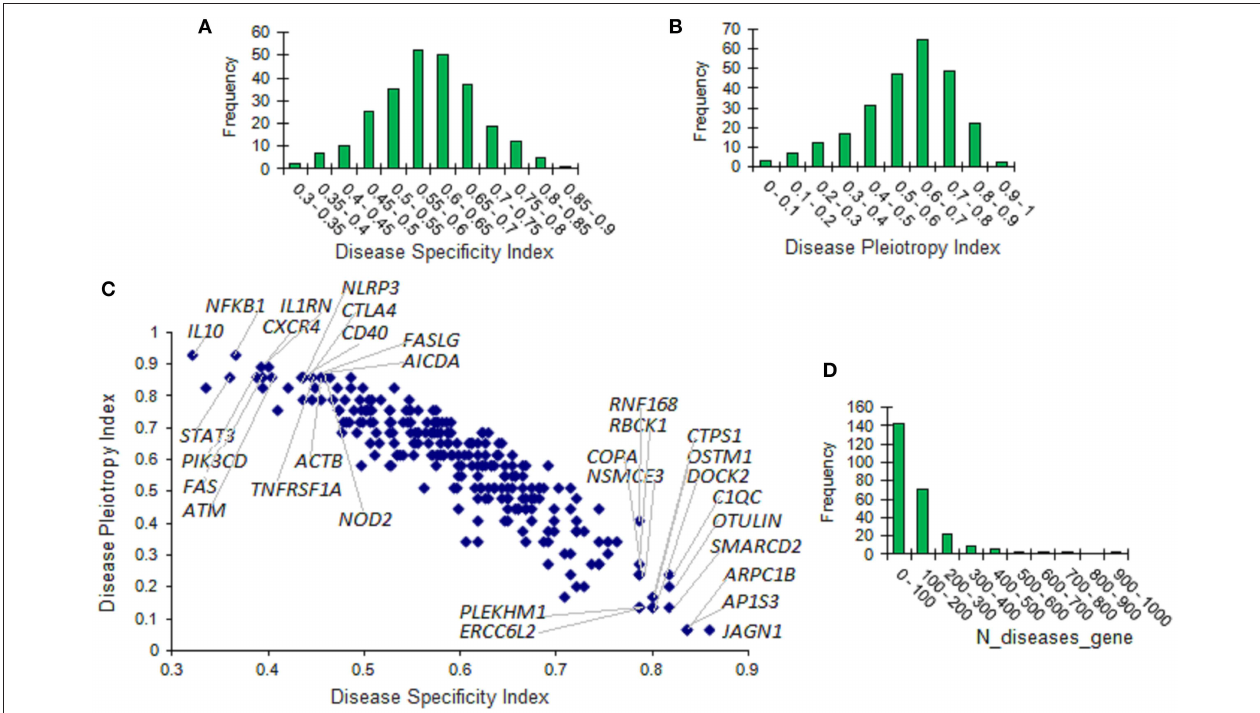
FIGURE 4 | Disease specificity and disease pleiotropy indexes of genes associated with inborn errors of immunity. (A) The distribution of the disease specificity index (DSI). (B) The distribution of the disease pleiotropy index (DPI). (C) Scatterplot of DSI and DPI. Ten top values are presented for DSI (15 genes) and DPI (16 genes). (D) The distribution of the number of associated